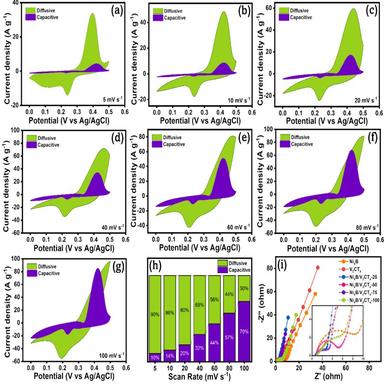
(a–g) Shaded CV curves for diffusive and capacitive contributions recorded at 5 to 100 mV s − 1 and (h) percentage contribution of diffusive and capacitive contributions as a function of scan rates and (i) fitted electrochemical impedance curve for all electrodes.